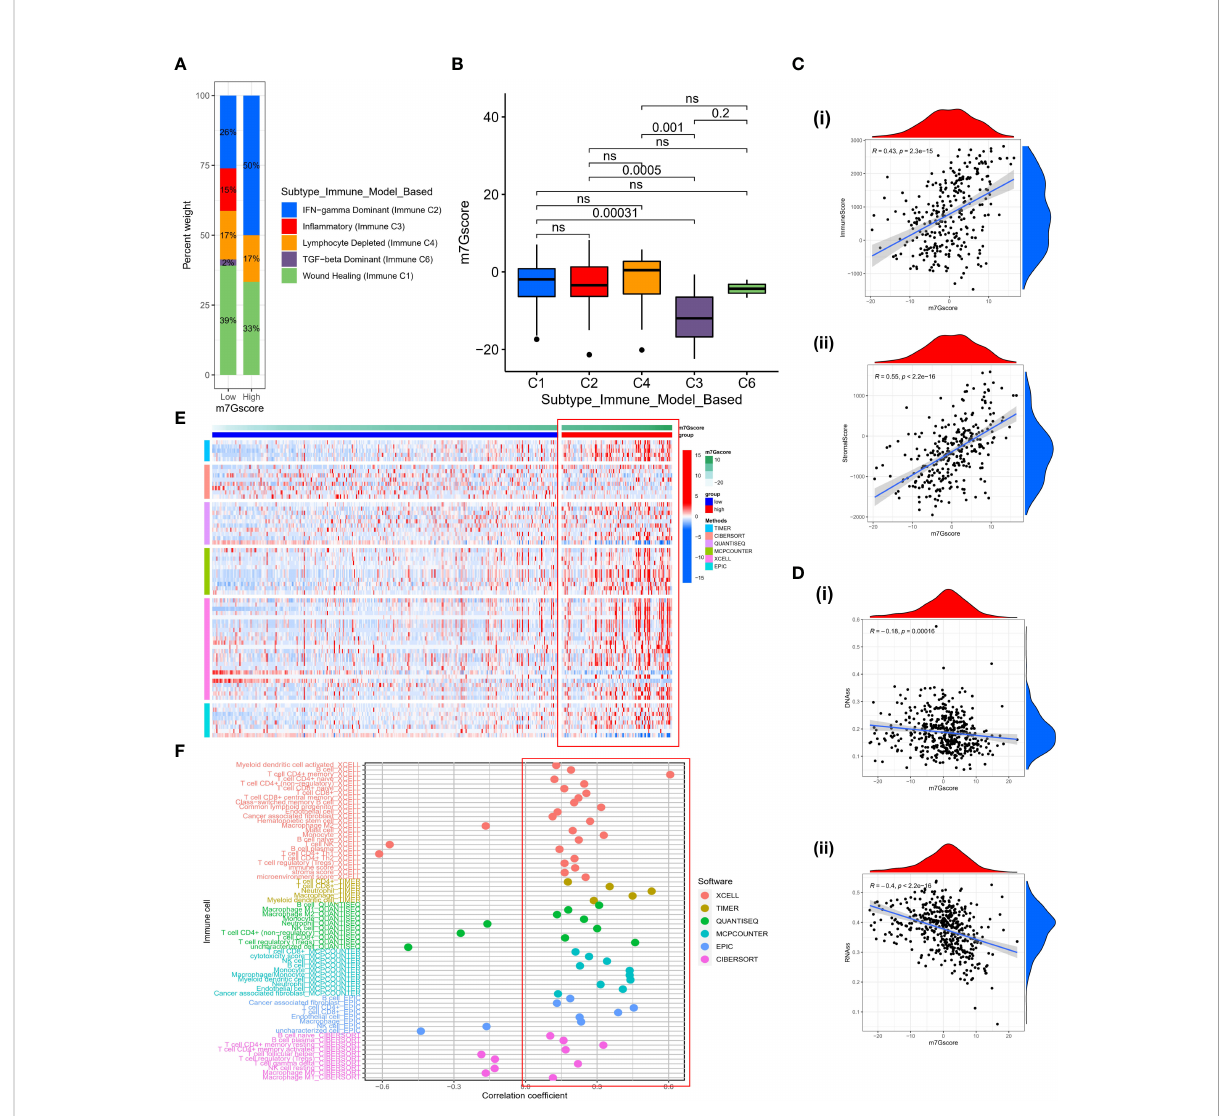
FIGURE 7 The characteristics of TME in high and low m7G score subgroups. (A) The fraction of Immune Subtypes in high and low m7G score subgroups. (B) The distribution of m7G score between different Immune subtypes. (C) The association between immune score (i) or stromal score (ii) and m7G score. (D) The relationship between DNAss (i) or RNAss (ii) and m7G score. (E) Heatmap of immune cell in fi ltration level based on TIMER, CIBERSORT, QUANTISEQ, MCP-counter, XCELL, EPIC algorithms. (F) The correlation between m7G score and activity of immune cells in TME. ns, no signi fi